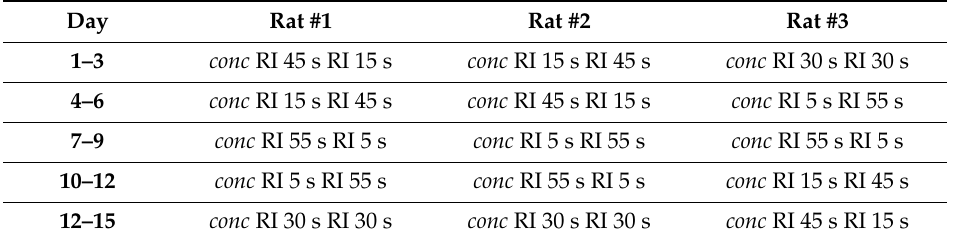
Table 1. Testing sequence of reinforcement schedules to assess steady-state matching behavior. Each column specifies reinforcement schedules that the respective subject was assigned to during the 15 days of